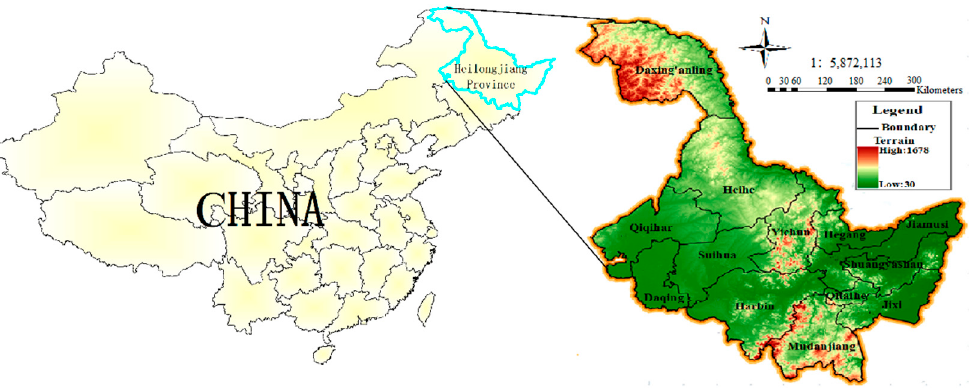
Figure 2. Map of the study area.